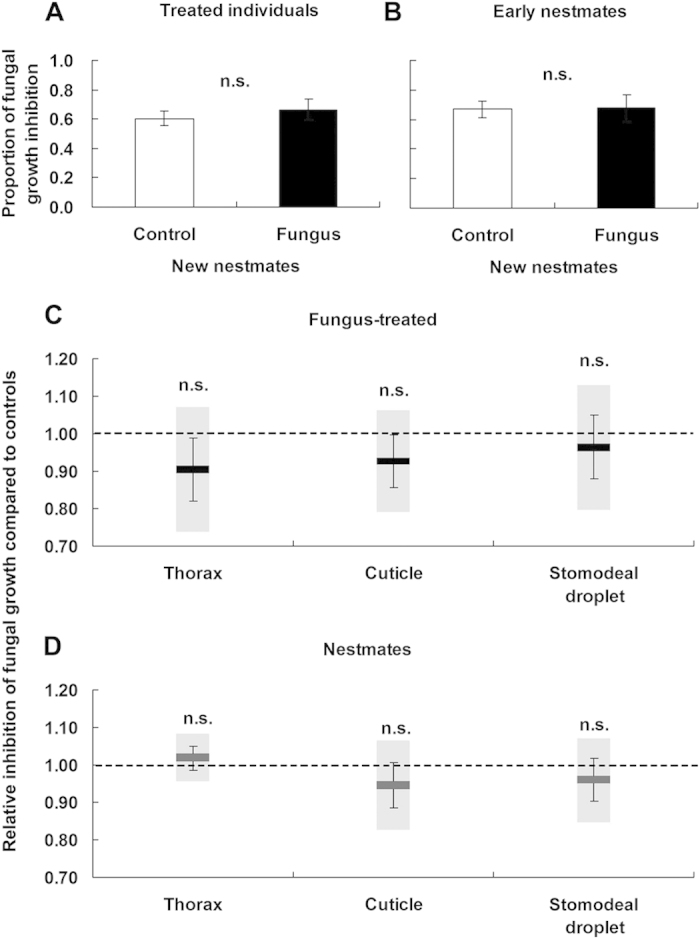
Antifungal activity assays of transferred antimicrobial substances.The antifungal activity of new nestmates of directly treated termites (A) and early nestmates (B) in a sham control assay (white bars) and under fungus treatment (black bars); Error bars represent mean ± SEM; n.s., not significant. Antifungal property of the exterior and interior of fungus-treated termites compared to control termites for directly treated termites (C) and their respective nestmates (D); Error boxplots represent mean ± SEM; n.s., not significant.